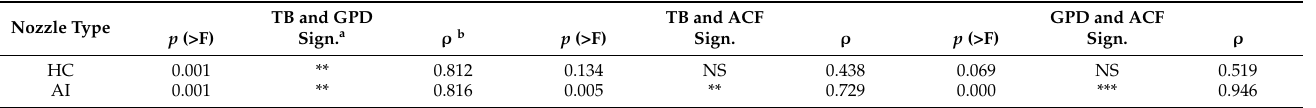
Table 6. Correlation among CDP values obtained from different collectors (respectively, test bench, ground petri dish, and airborne collection frame) for the HC and AI nozzle.